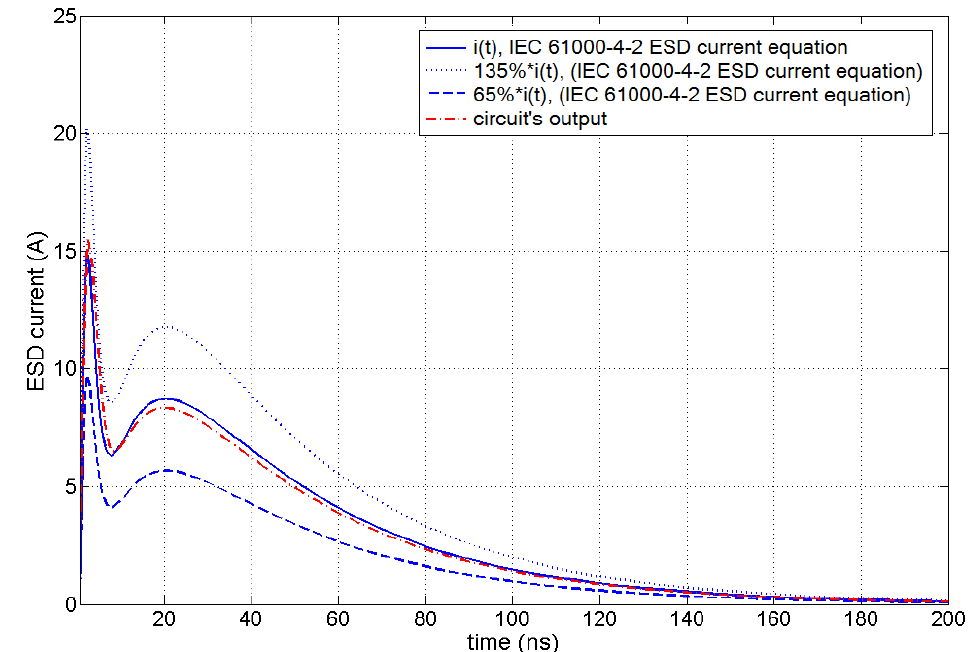
Figure 8. Plot of the output of the circuit of Figure 9, together with the IEC 61000-4-2 Standard equation for the ESD current at +4 kV and the tolerance set by the